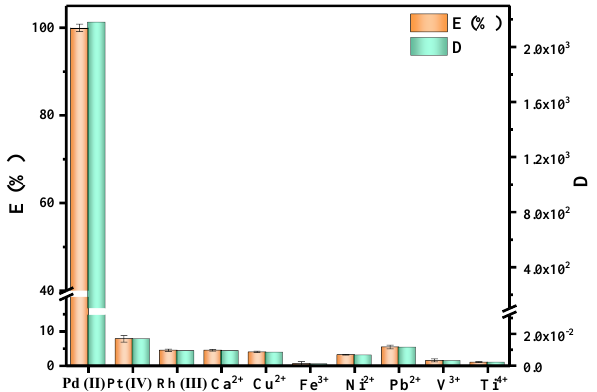
Figure 6. Separation of Pd (II) from the metallurgical wastewater. m PS-DMTD = 0.1 g, C Pd (II) = 109 mg/L, pH = 1.0, T = 298.15 K, t = 240 min, and V = 0.02 L. C Pd (II) = 109 mg/L, pH = 1.0, T = 298.15 K, t = 240 min, and V = 0.02 L.